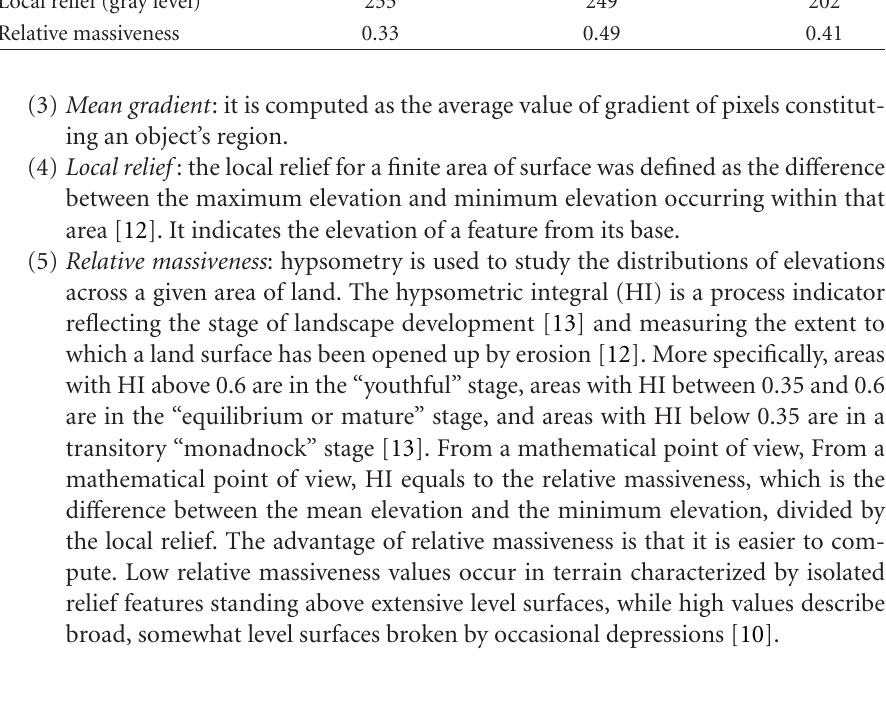
Figure 3.1. The DEM of Great Basin. The elevation values of the terrain (minimum 1005 meters and maximum 3651 meters) were rescaled to the interval of 0 to 255 (the brightest pixel has the highest elevation). Table 3.1. Statistics of the study area, peak regions, and the pit regions. Parameter Study area Peak regions Pit regions Area (pixels) 91123 6010 1417 Mean elevation (gray level) 85.11 127.58 82.64 Mean gradient ( ◦ ) 5.94 8.95 3.52 Local relief (gray level)